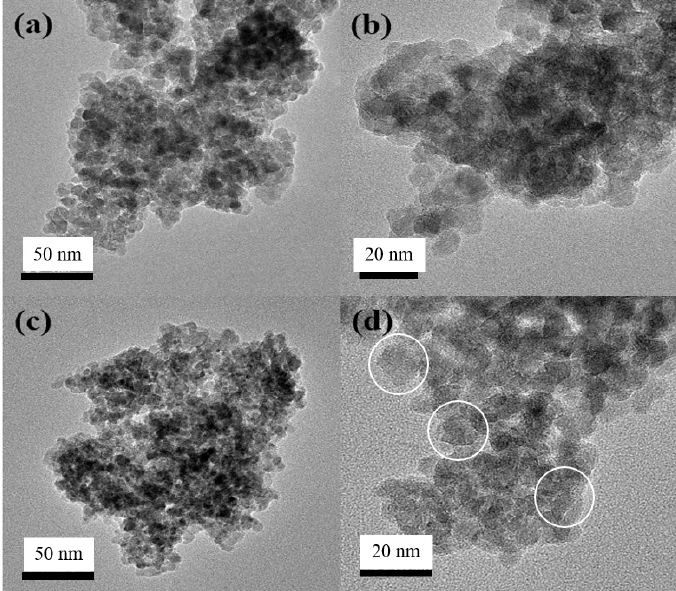
Figure 6. TEM images of ( a , b ) undoped TiO 2 samples and ( c , d ) S,N-doped TiO 2 samples.